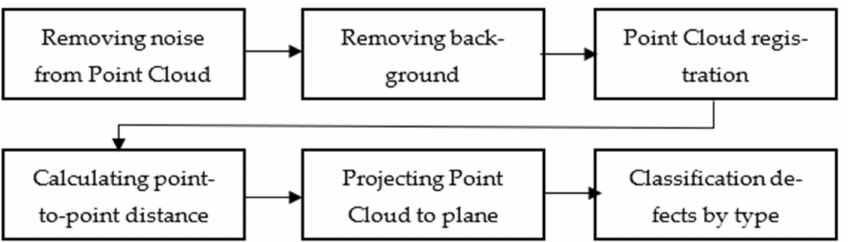
Figure 13. Defect detection and classification flow chart.